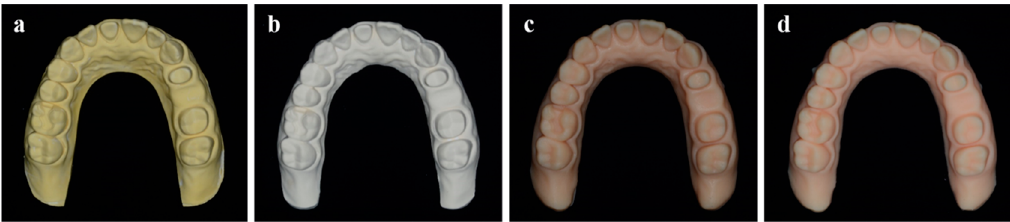
Figure 2. Experimental models. ( a ) Conventional gypsum model (CON); ( b ) milled gypsum model (MIL); ( c ) SLA 3D printed photopolymer model (S3P); ( d ) DLP 3D printed photopolymer model